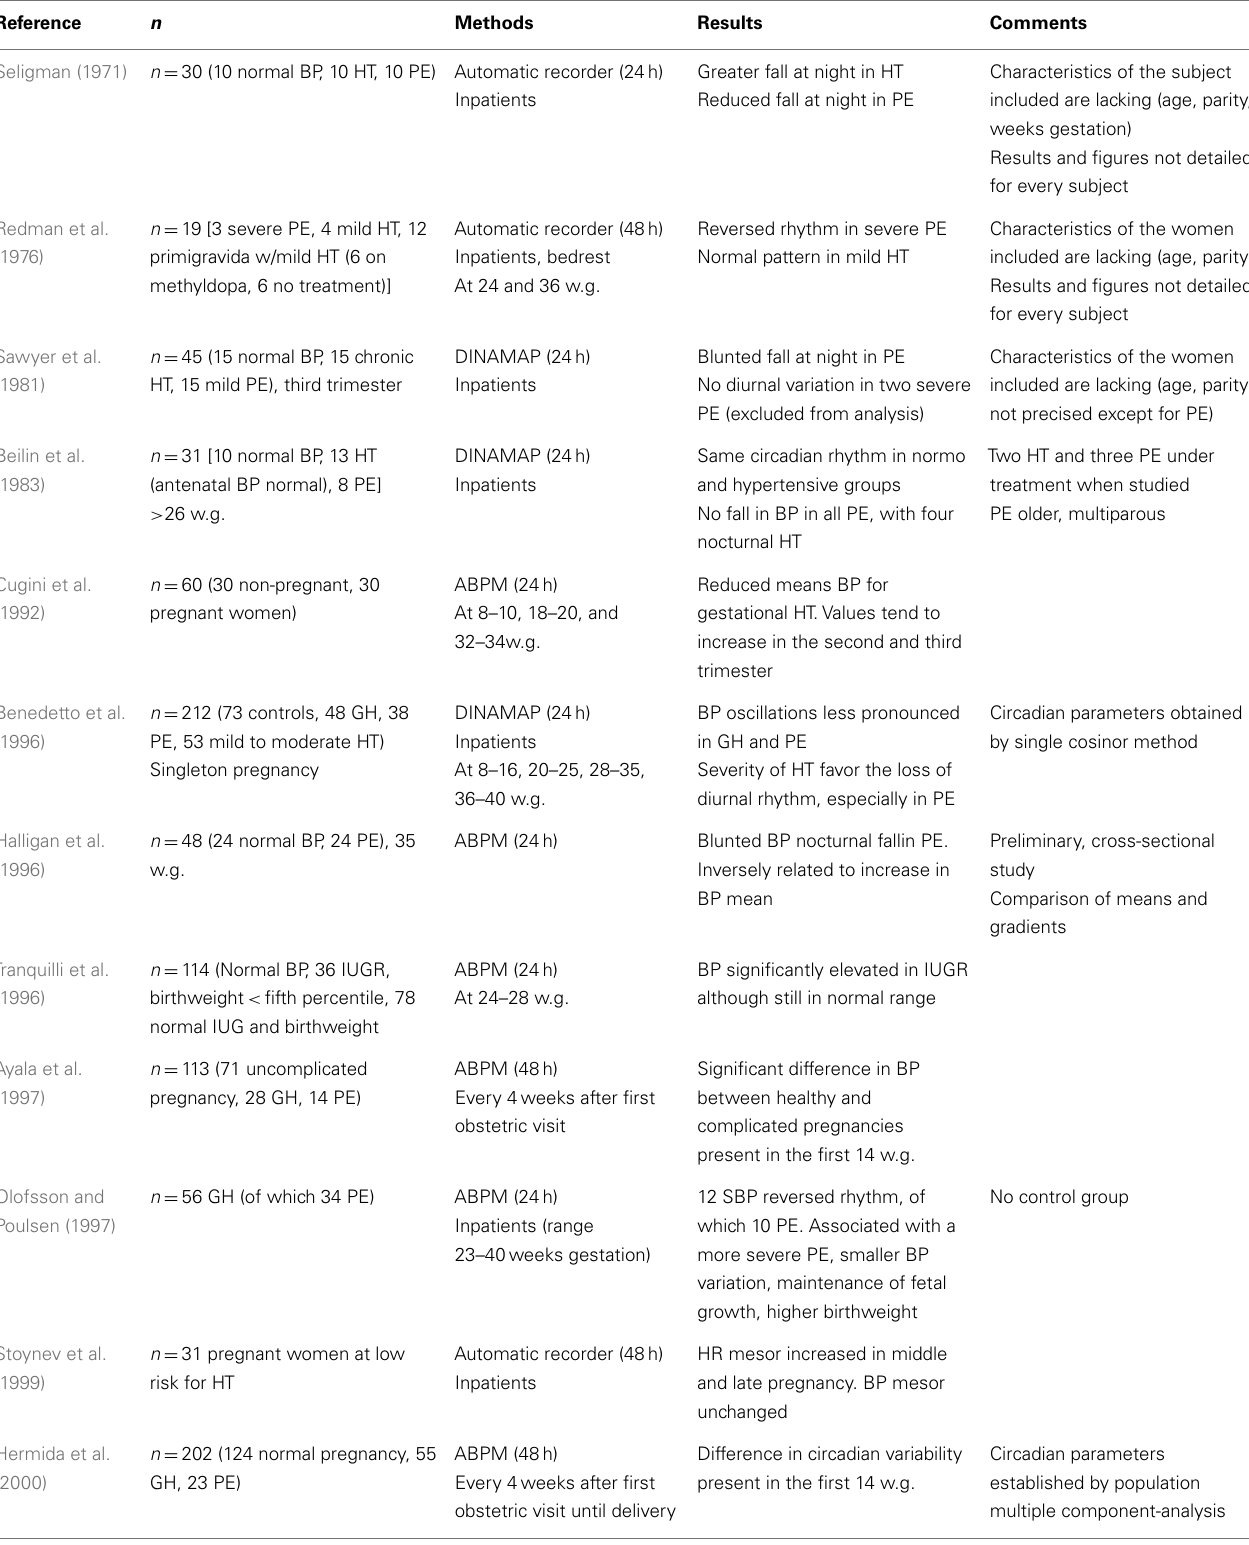
Table 1 | Summary of the main studies on BP and circadian pattern during normal and abnormal